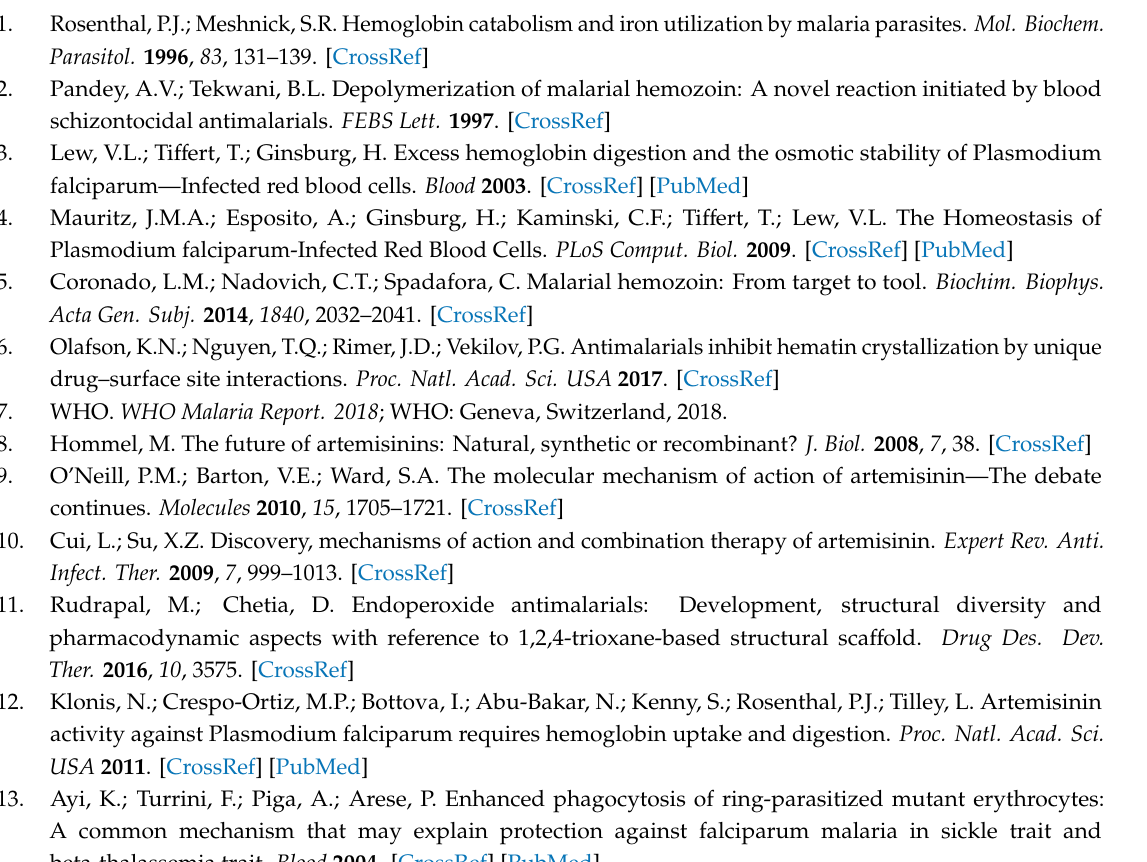
Figure S1. E ff ect of RBC treatment with P505-15 (0.5 µ M) and DHA (0.5 nM) on the accumulation of HMC after 12 h of incubation. Data are the average of five experiments ± SD; Figure S2 E ff ect of pRBC treatments with a representative Syk inhibitor (P505-15) (0.5 µ M) and DHA (0.5 nM) on the accumulation of HMC after 3, 6, 12, and 24 h. Data are the average of five experiments ± SD. Significant di ff erences to untreated pRBCs at * p < 0.05; ** p < 0.001; Figure S3. Isobolograms showing the interactions between Syk Inhibitors (P505-15 and imatinib) and dihydroartemisinin (DHA), after 24 h of incubation in the P. falciparum Palo Alto strain treated with G6PD-d red cells; Table S1. Combination index (CI) (Chow-Talalay) of di ff erent SYK